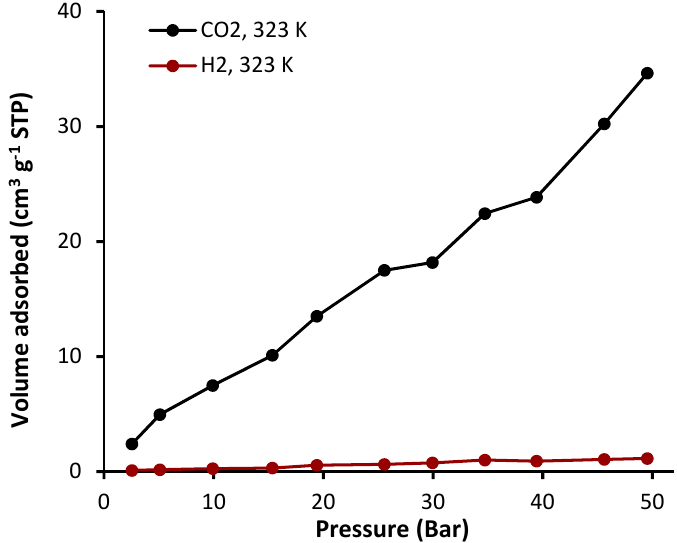
Figure 11. Adsorption isotherms of CO 2 and H 2 for complex 4 .